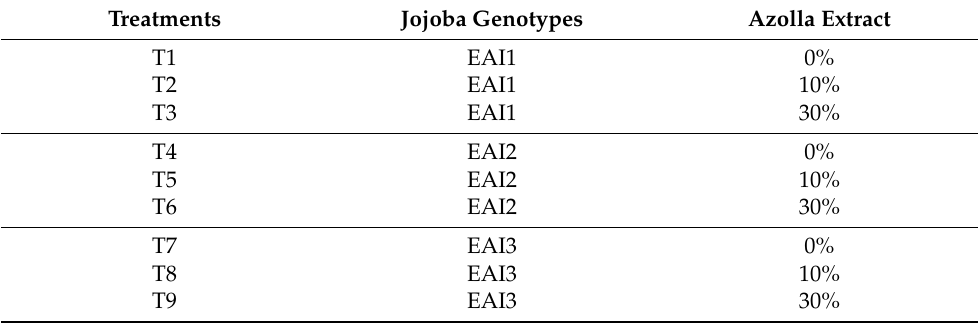
Table 12. The combined treatments of jojoba genotypes and Azolla filiculoides Lam. plant